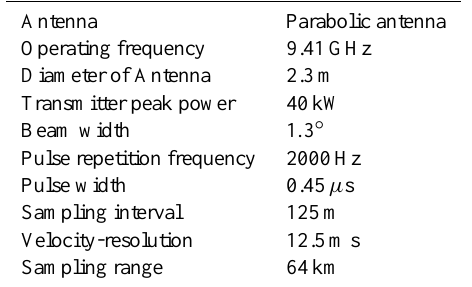
Table 2. Specifications of the X -band DR.